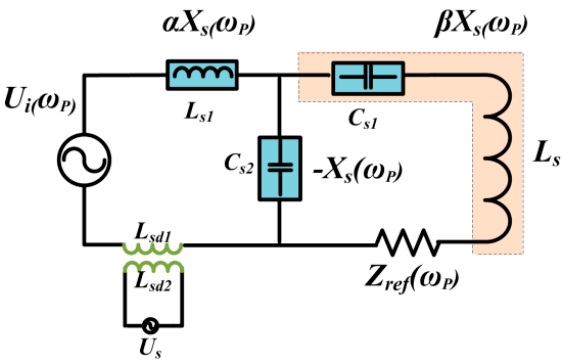
Figure 7. Diagram of the primary side of the proposed SWTPI system at the power frequency.